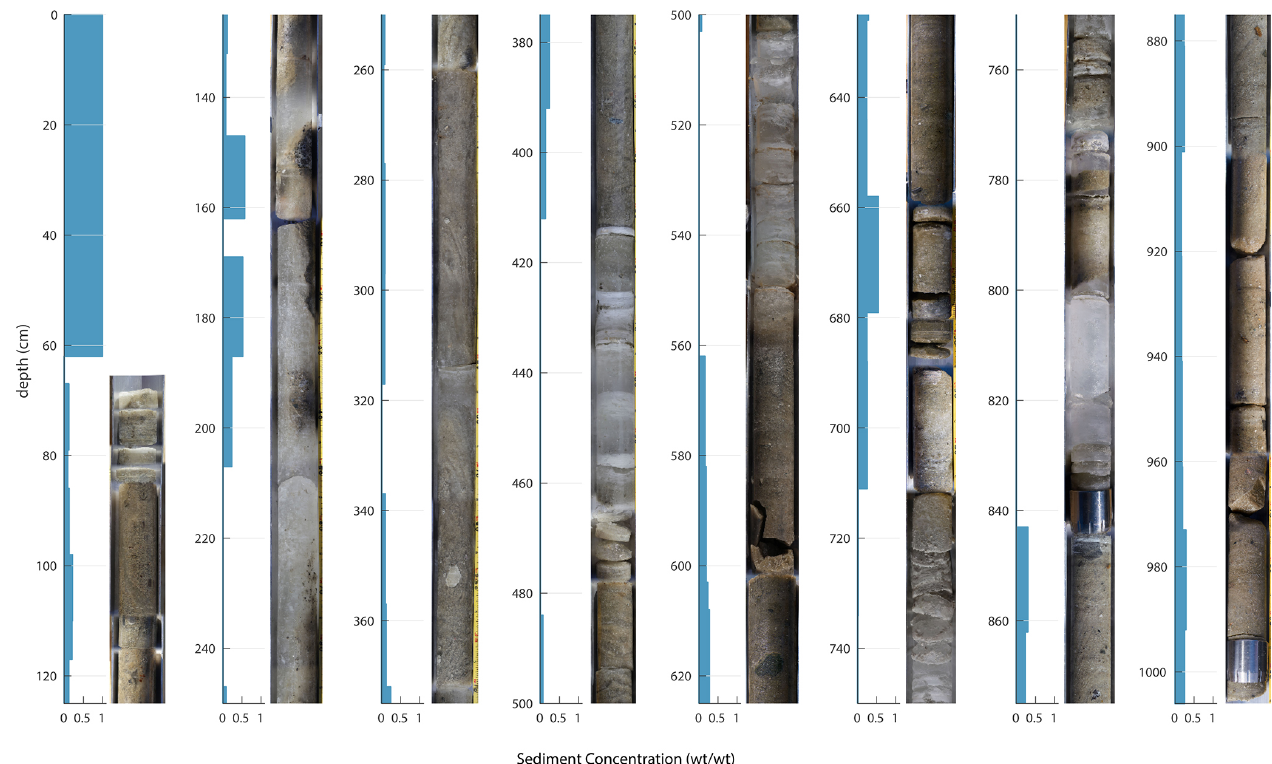
Figure 5. Image of the 17-OD1 ice core. The full image is stitched together from multiple individual pictures each covering approximately 20cm of core length. The blue graph shows the corresponding debris concentration calculated by weight at depth below the surface. The topmost 62cm is the thickness of the overlying supraglacial debris layer (not shown in pictures). See the complete ice core image in the